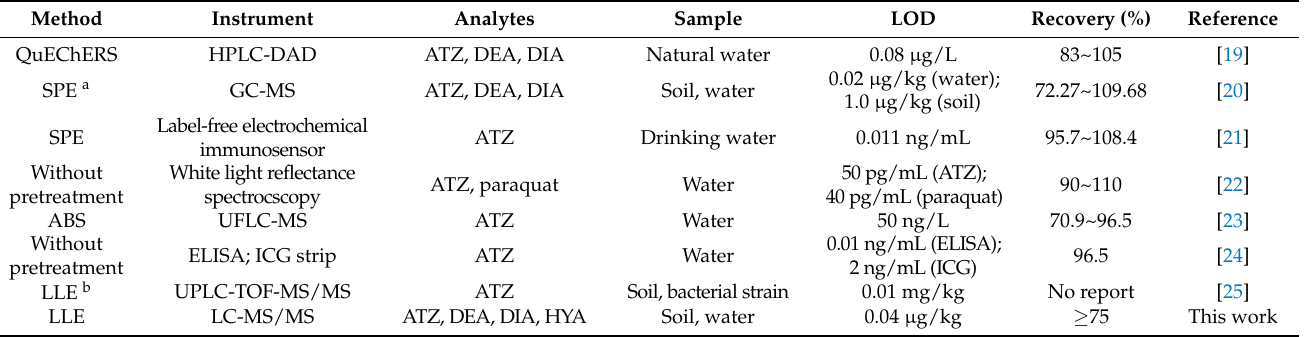
Table 3. Comparison of the method with other techniques for ATZ and its metabolites